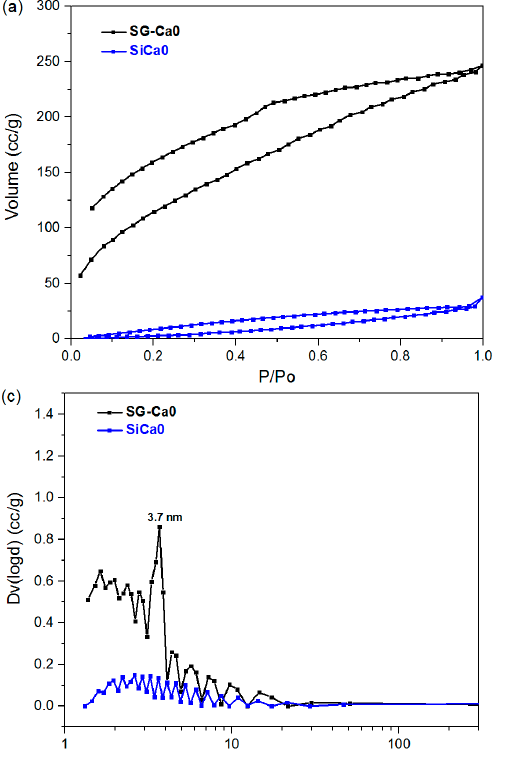
Materials 2019 , 12 , x FOR PEER REVIEW 9 of 14